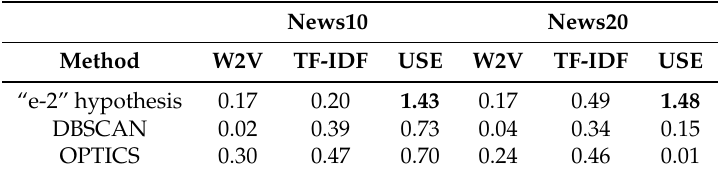
Table 6. NMI for News10 and News20.